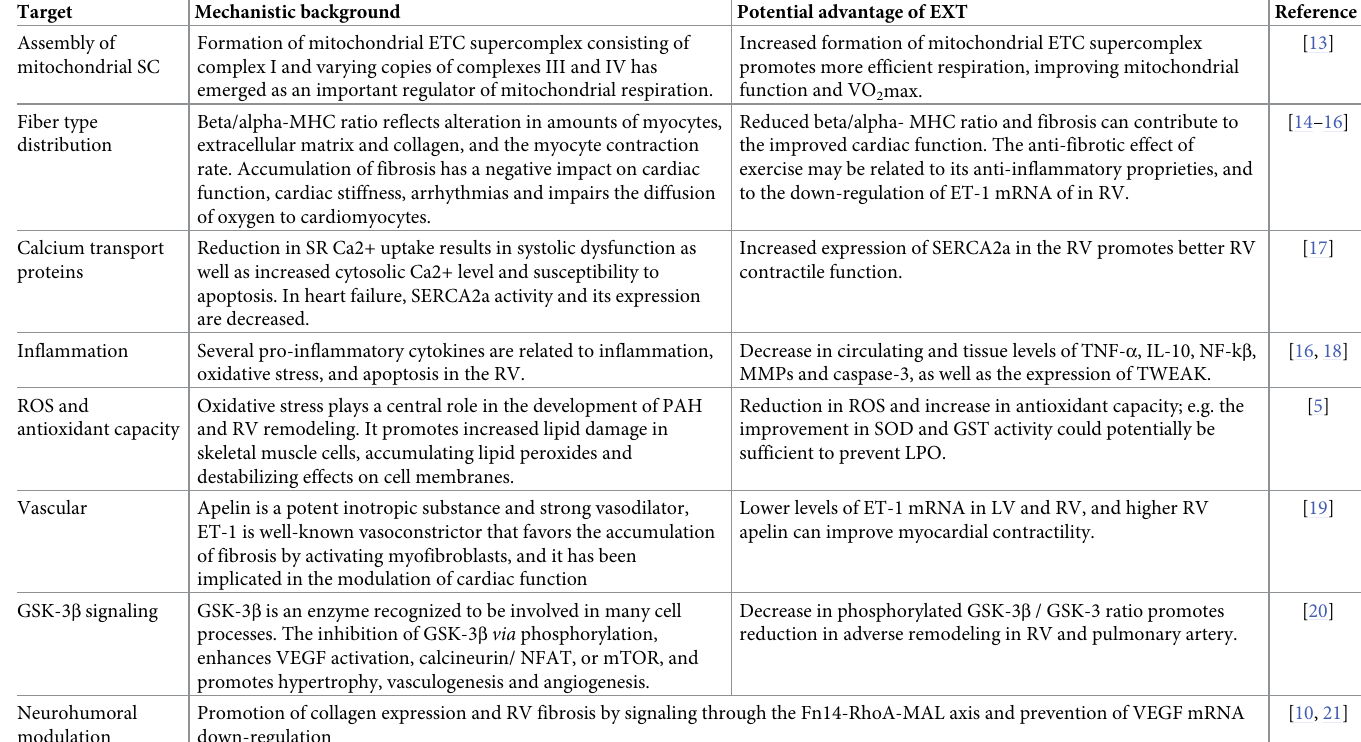
Table 1. Summary of potential mechanisms underlying the beneficial effects of chronic exercise training in animal models of pulmonary hypertension. Target Mechanistic background Potential advantage of EXT Reference Assembly of mitochondrial